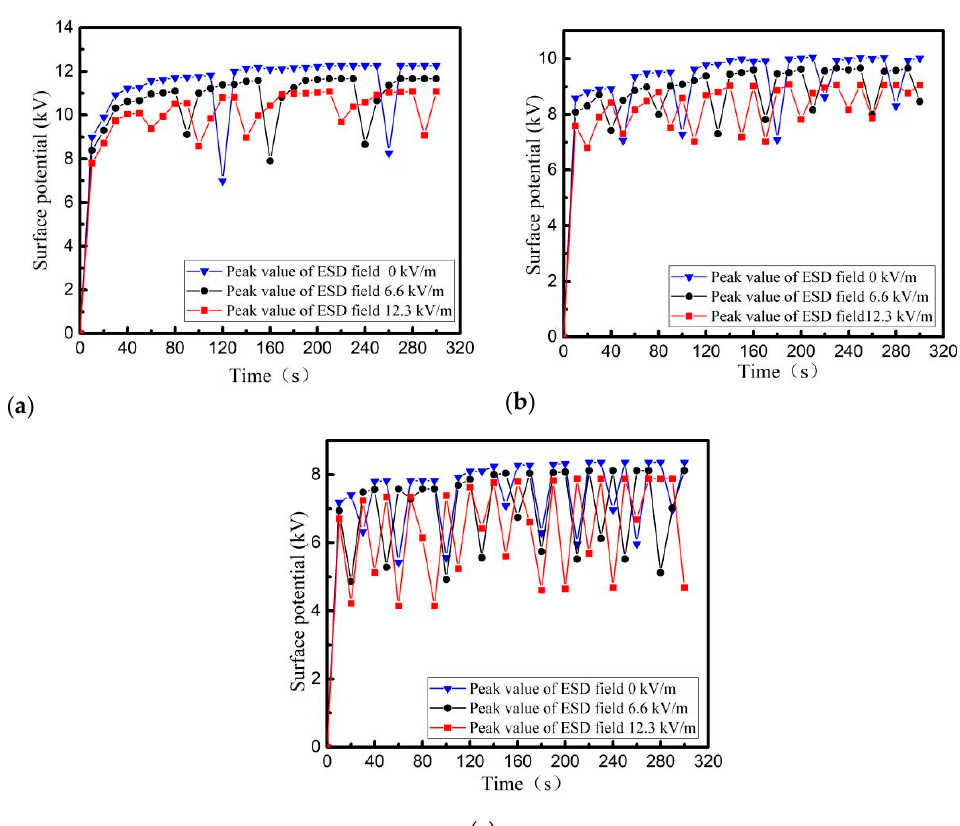
Figure 8. Changes of charging potential on dielectric surface under different radiation field strength ( a ) PTFE, ( b ) PI, ( c ) EP.